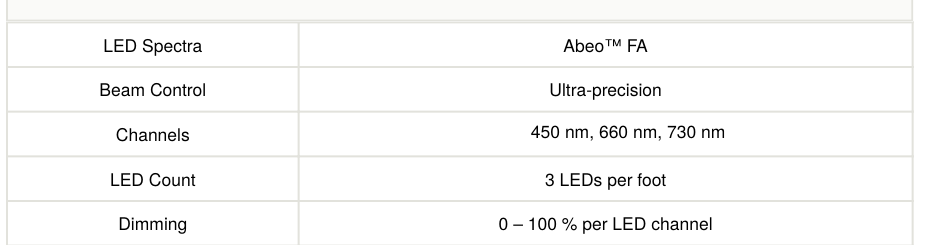
LED Lighting System ILLUMITEX Quantum Horticulture Plant Research